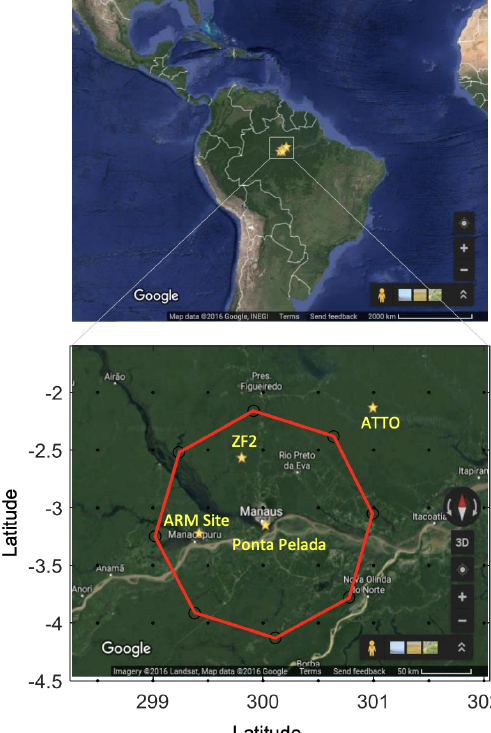
Figure 1. Data collection area of the GoAmazon 2014/15 exper- iment and domain of VARANAL analyses (red octagon). Images extracted from Google (map data © 2016), INEGI and Landsat (im- agery © 2016). Source: Tang et al.